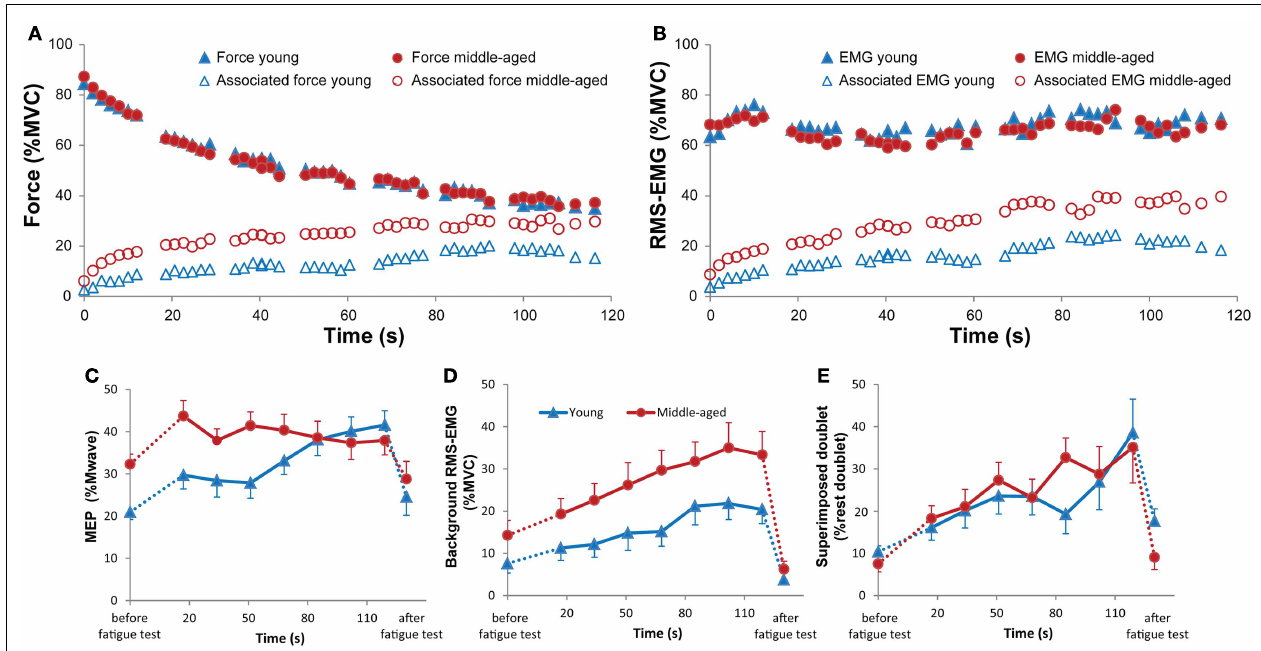
the sustained contraction.The analysis demonstrated aTime by Age group interaction ( p = 0.006), revealing a decrease in MEP difference between the two Age groups with time. (D) Changes in mean (and standard error) RMS-EMG 100ms before theTMS pulse. First and last values are the values obtained during the contralateral MVC. Note that the background RMS-EMG is associated activity. In contrast to the MEPs, the amount of ipsilateral activity increased progressively during the sustained contraction of young and middle-aged subjects ( p < 0.001). (E) Changes in the mean (and standard error) superimposed doublet-force evoked in the FDI muscle that produces the maximal force during the sustained contraction.The doublet twitch increased throughout the sustained contraction reflecting a progressive decline in voluntary drive ( p = 0.005), without a difference between the two